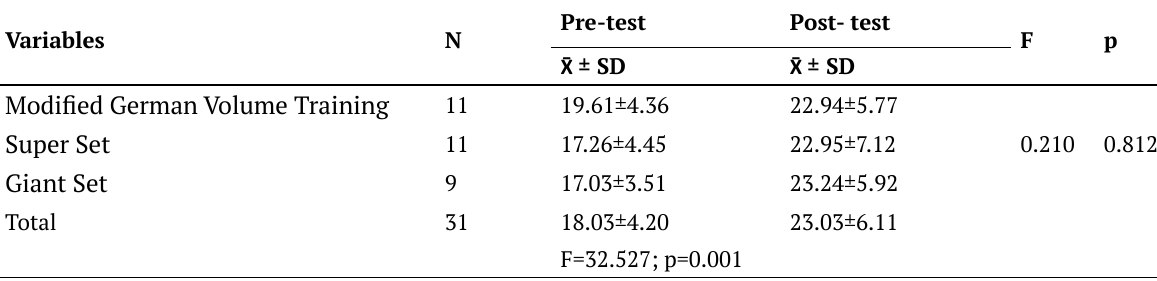
Table 8. Pre-test and post-test comparison of the bench press values of the groups